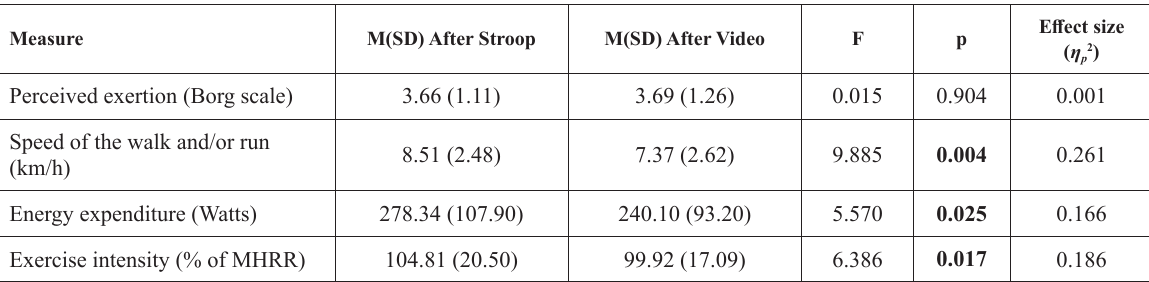
Figure 2. Heart rate profiles in two experimental conditions